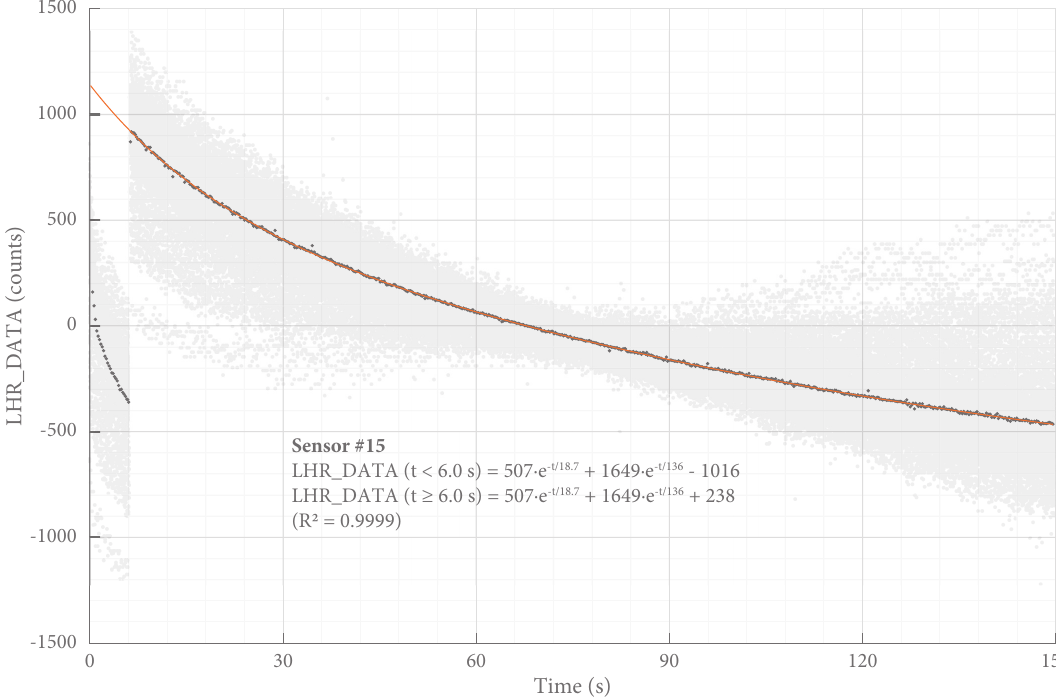
Figure 5. Start-up effect. The output signal gradually decreases every time the SLU is started. For this graph, the SLU was programmed to take ten 150 s measurements per hour, (gray). For all timestamps, the mean was calculated (dark gray), and least squares regression was used to find the best fit to a double exponential function (orange). The typical sensitivity (Table 2) can be used to convert LHR_DATA to a measure for force: 1500 counts approximate 0.01 N.